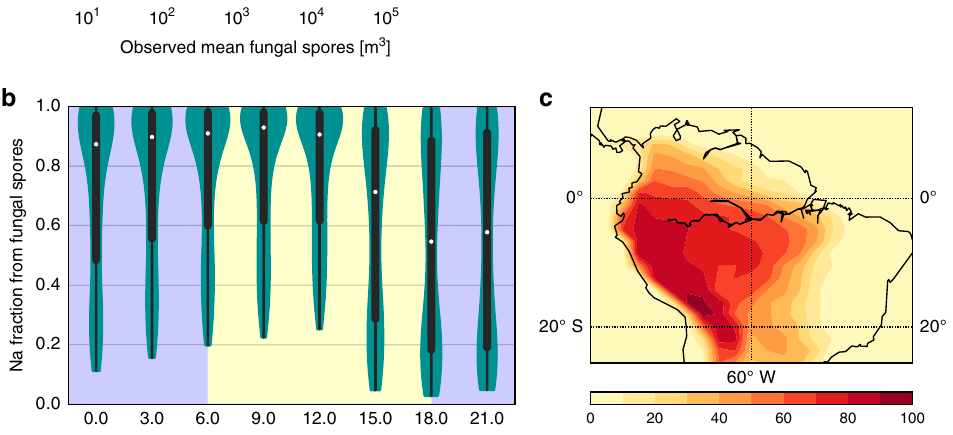
Chemical imaging of particles . An environmental scanning electron microscope (Quanta 3D model, FEI, Inc.) with an EDAX TM EDX spectrometer and a Si(Li) detector with a 10 mm 2 active area and an ATW2 window was used under vacuum conditions for imaging and X-ray microanalysis. Particles were imaged using secondary electron (SE) and forward scattered transmitted electron (STE) signals. STE imaging mode was used for particle identi fi cation and CC SEM/EDX analysis. X-ray spectrum for each identi fi ed particle was acquired at an acceleration voltage of 20 kV and at a beam current of 430pA for 10 s. The CC SEM/EDX analysis automatically investigates the speci fi ed scanning area and detects particles in the speci fi ed fi elds of view. In this way, we can detect ~90% of the particles deposited on the grid. Particles collected on the edges (~5 – 10%) of the Cu mesh were excluded from the results based on their high Cu background signal. We analyzed ~80% of the particles that were collected onto TEM B- fi lm grids placed on stages 4 and 5 of the impactor. Area equivalent diameters were calculated from the two- dimensional projected area recorded for each individual particle. Particle elemental